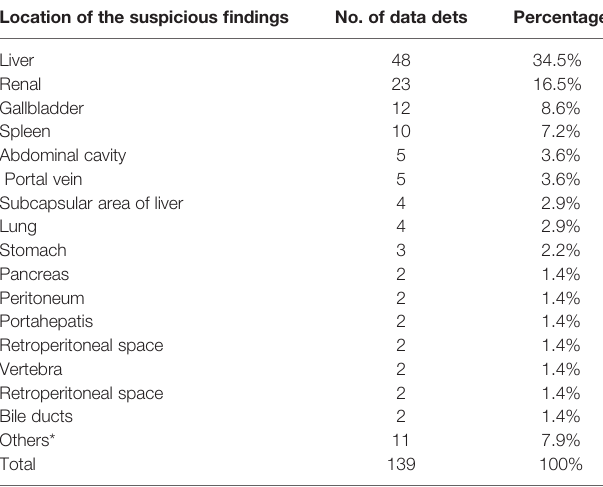
TABLE 3 | Distribution of suspicious fi ndings for patients. Location of the suspicious fi ndings